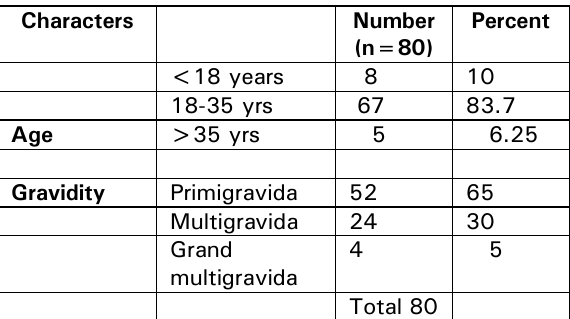
Table 1: Demographic characteristic of patients